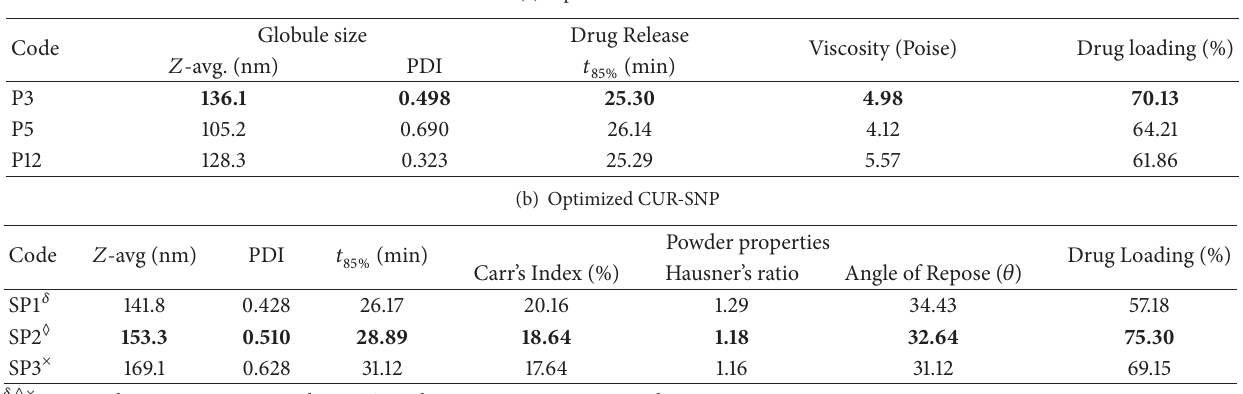
Table 4: Evaluation parameters of optimized CUR-LNP and